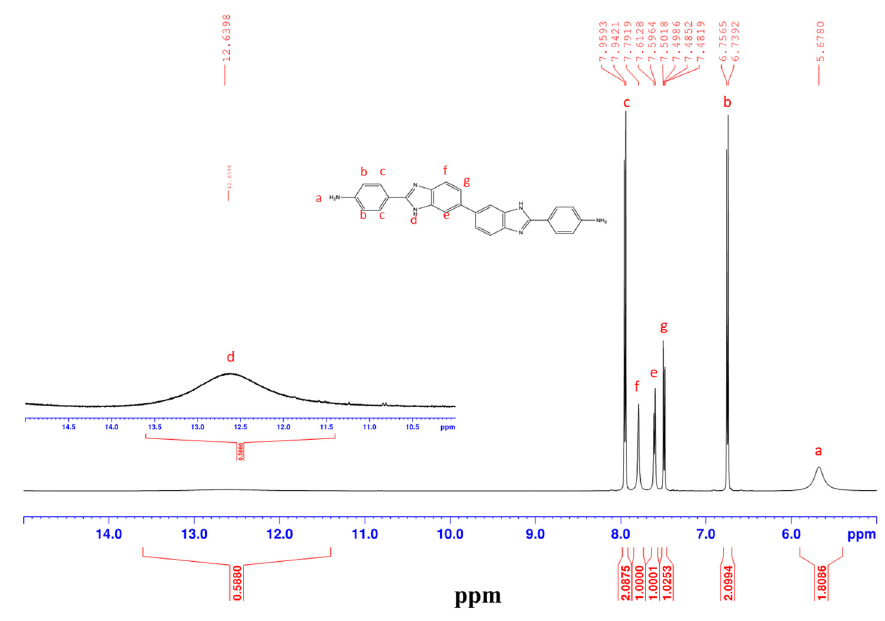
Figure 2. 1 H NMR spectra of BAPBI monomer in DMSO- d 6.